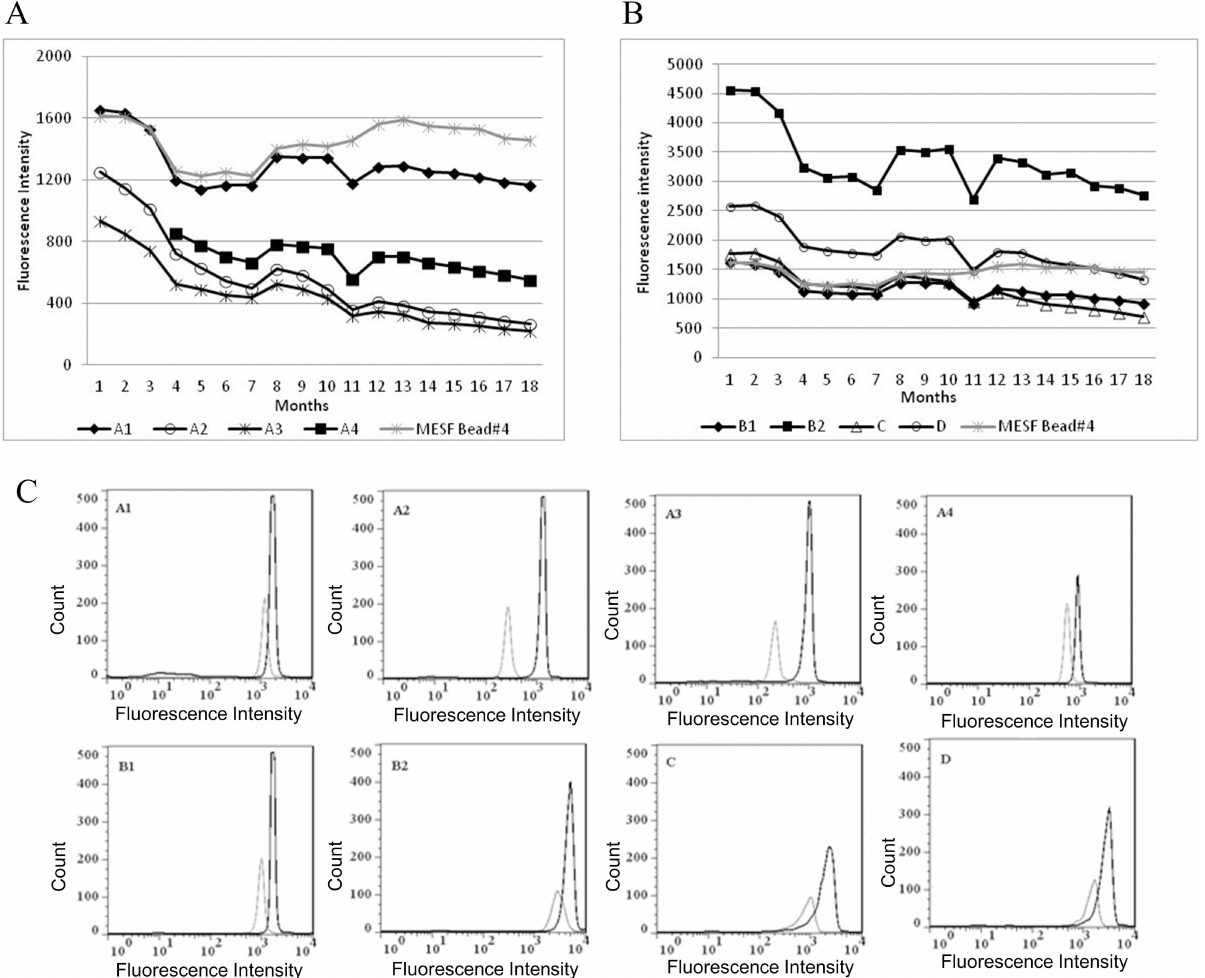
Fig 5. Conjugate stability study during 18 months. A: A1, A2, A3, A4 and MESF bead #4 fluorescence intensitiesduringthe months of analysis. B: B1, B2, C, D and MESF bead #4 fluorescence intensities duringthe months of analysis. C: Conjugates histograms of PE- fluorescence intensity (X axis) vs. count (Y axis) on the first month (black peak) and last month of analysis(white peak). MESF bead #4 was includedas an exampleof the MESF kit used to control instrument performance during the 18 months of evaluation. The A4 conjugatewas coupledlater than the other conjugatesand its intensities evaluation started at month